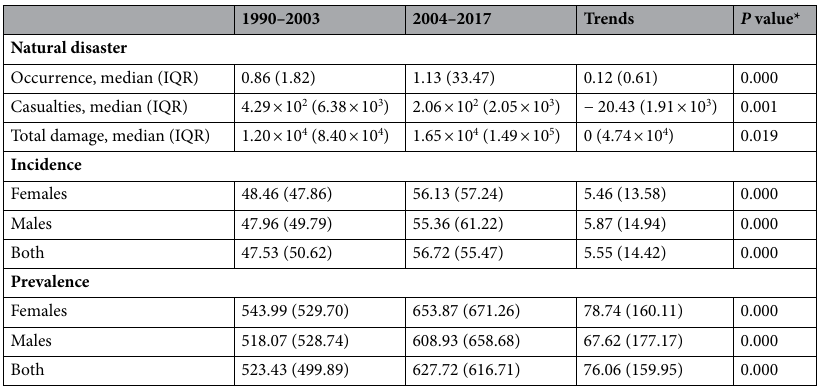
Table 1. Summary statistics of natural disaster impacts and incidence and prevalence of ischemic stroke during two periods in 193 countries. *Wilcoxon signed-rank